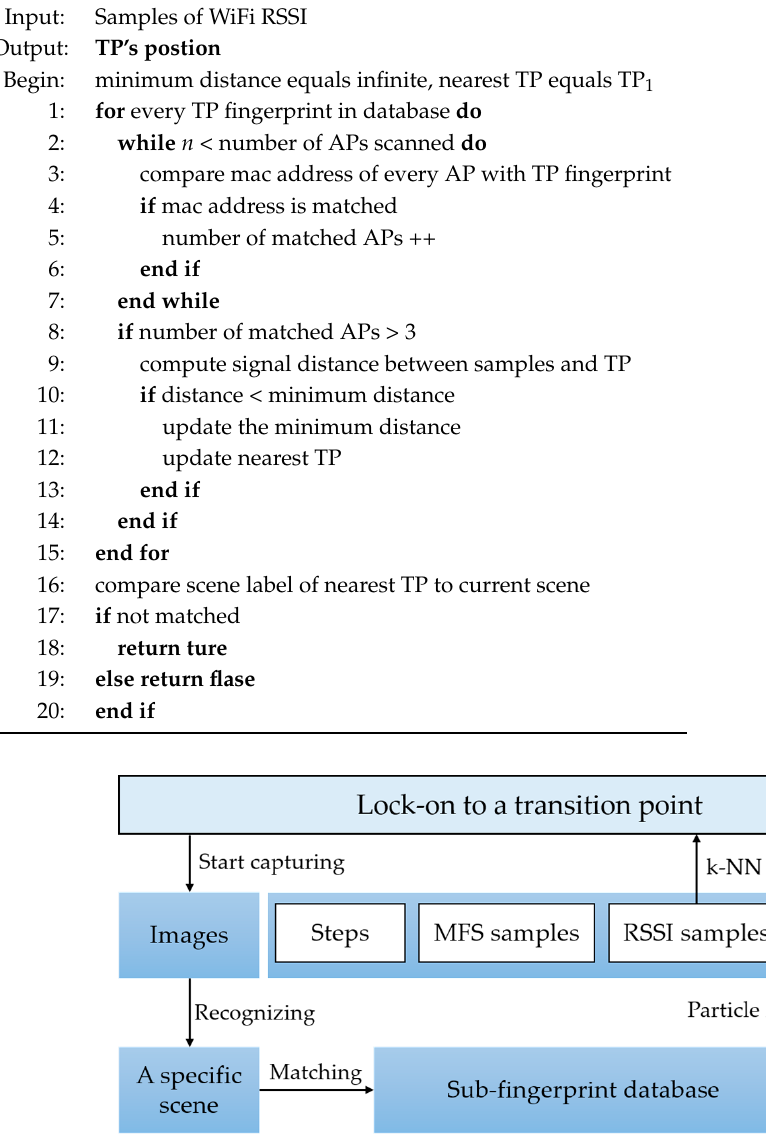
Algorithm 1. Ttransition Point Detection.